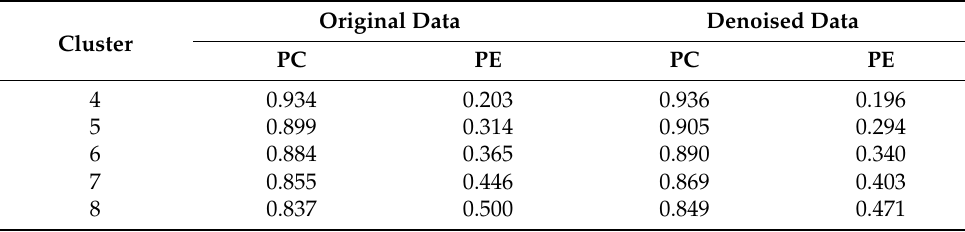
Table 4. Clustering performance comparison of different datasets for Dataset 1.